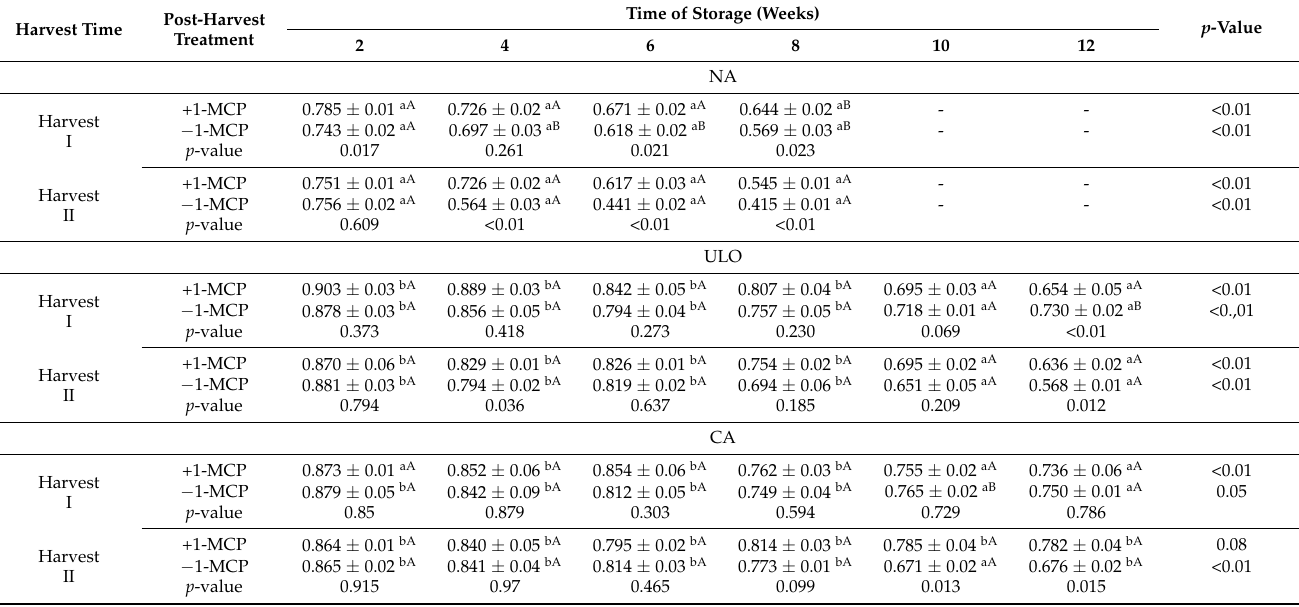
Table 7. Changes of titratable acidity (%) measured in ‘Ananasnaya’ mini kiwi fruit in the post- harvest